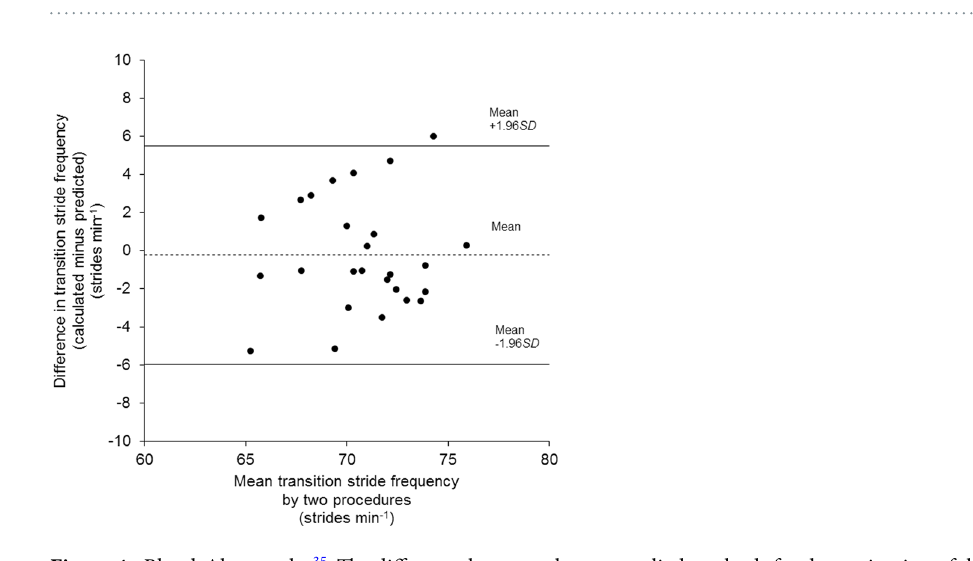
Figure 4. Bland-Altman plot 35 . The difference between the two applied methods for determination of the transition stride frequency (predicted and calculated) is depicted as a function of the mean value by the two methods ( n = 26). The mean difference of − 0.3 strides min − 1 is illustrated by a broken line while ± 1.96 × SD thresholds of 5.5 and − 6.0 strides min − 1 are illustrated by solid lines. A two-tailed Pearson product-moment correlation was applied for correlation analysis. The coefficient of determination ( R 2 ) is 0.004 ( P =